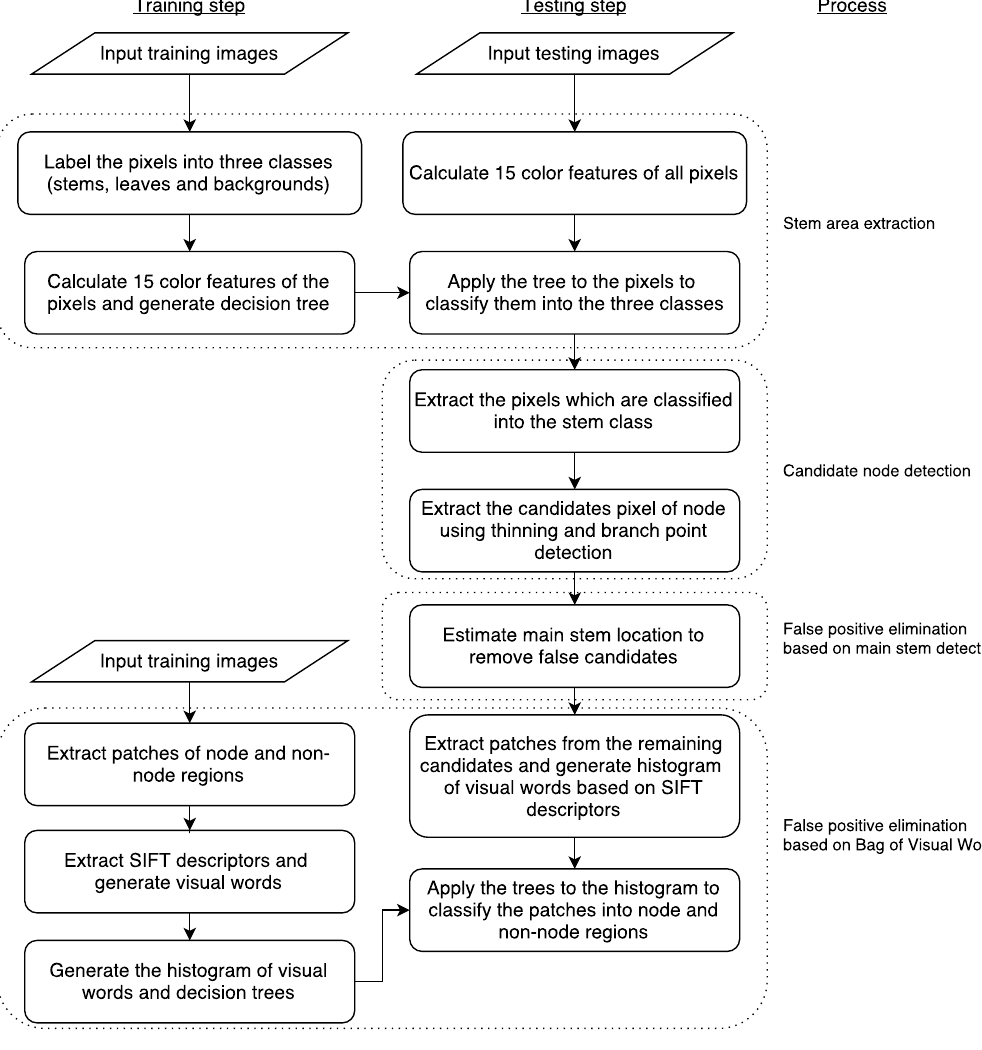
Figure 1. Flowchart of the developed method for node